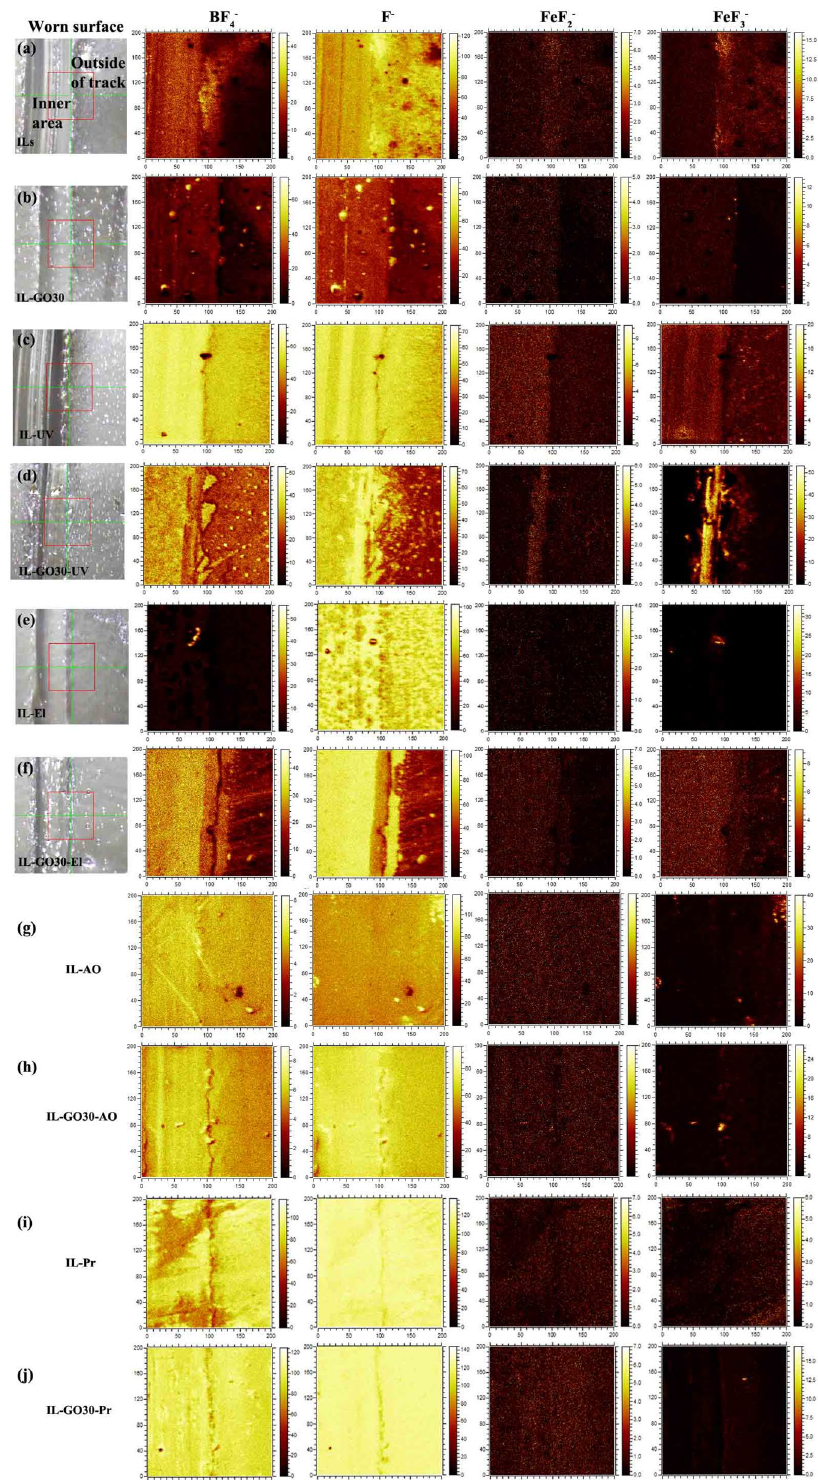
Figure 7. TOF-SIMS image of worn surface lubricated by ILs and IL-GO30 before and after irradiation; from left to right: analyzed area, F − , BF 4− , FeF 2− , and FeF 3–